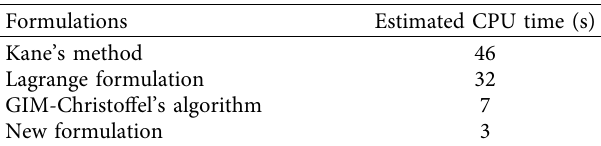
Figure 4: Joints profle computed by (a) the proposed method and (b) Kane’s method. Table 3: Computational